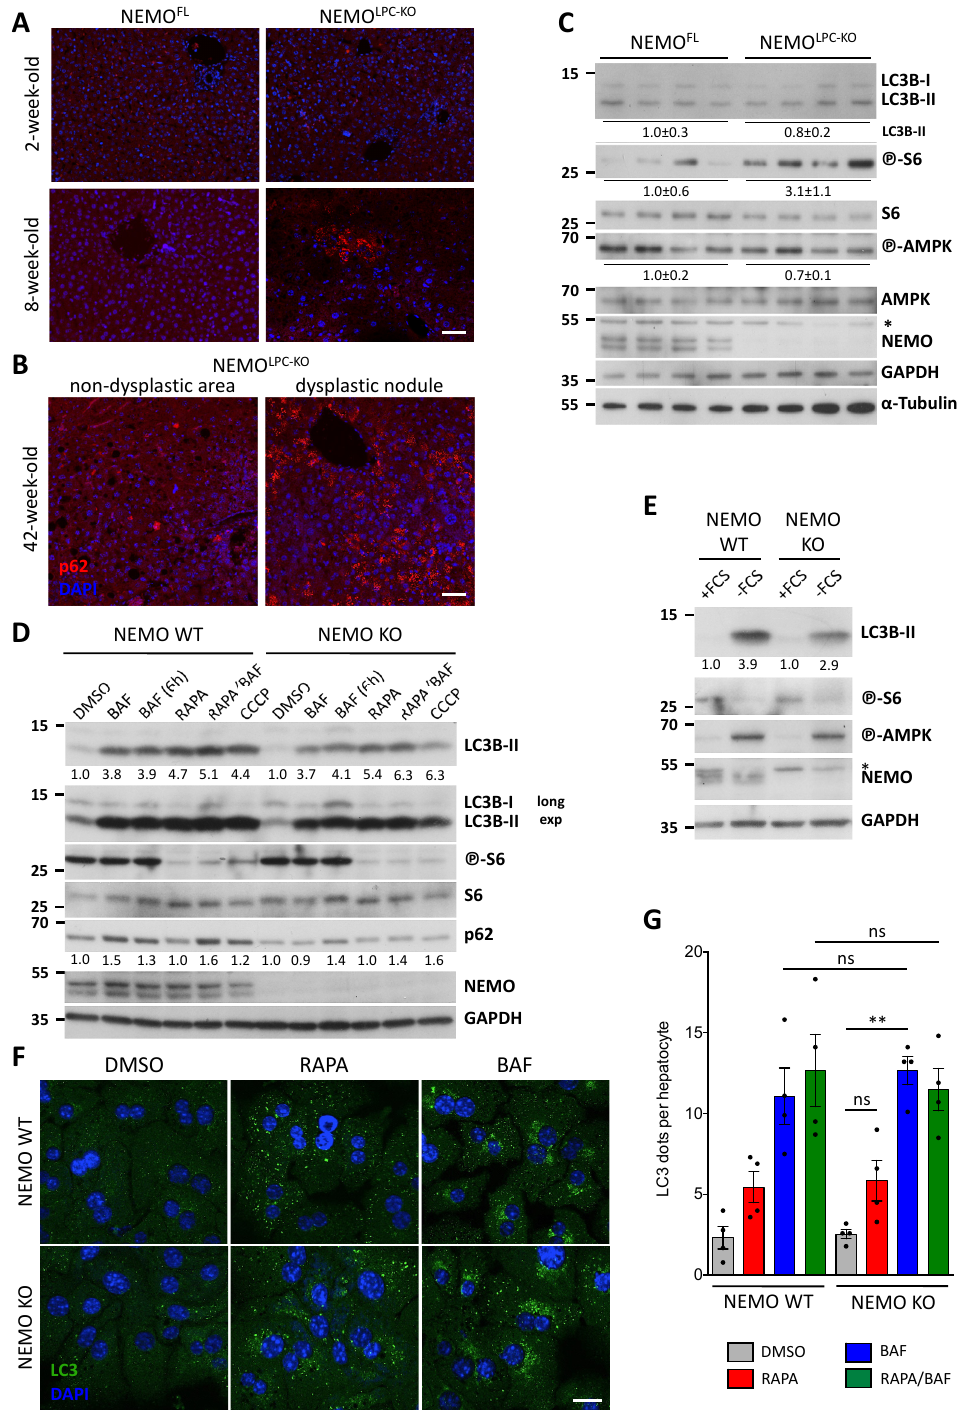
Figure 1. Progressive accumulation of p62, but no impairment in autophagosome formation in hepatocytes of NEMO LPC-KO mice. ( A , B ) Representative images of IF immunostaining for p62 performed on liver sections from 2-, 8- and 42-week-old NEMO LPC-KO mice and age-matched controls. Note in ( B ) the strong increase in p62 aggregates in hepatocytes of tumor/dysplastic areas compared to non-tumor areas of NEMO LPC-KO mice. DAPI is used to stain the nuclei. ( C – E ) Immunoblot analysis of the indicated proteins in total liver lysates from 8-week-old NEMO LPC-KO mice and age-matched controls ( C ), or in total lysates from control (WT) and NEMO-deficient (KO) primary hepatocytes treated with bafilomycin A1 (BAF) for 2 or 6 h, rapamycin (RAPA) for 2 h, CCCP for 2 h ( D ), and upon serum (FCS) starvation for 24 h ( E ). Asterisks indicate non-specific bands. GAPDH